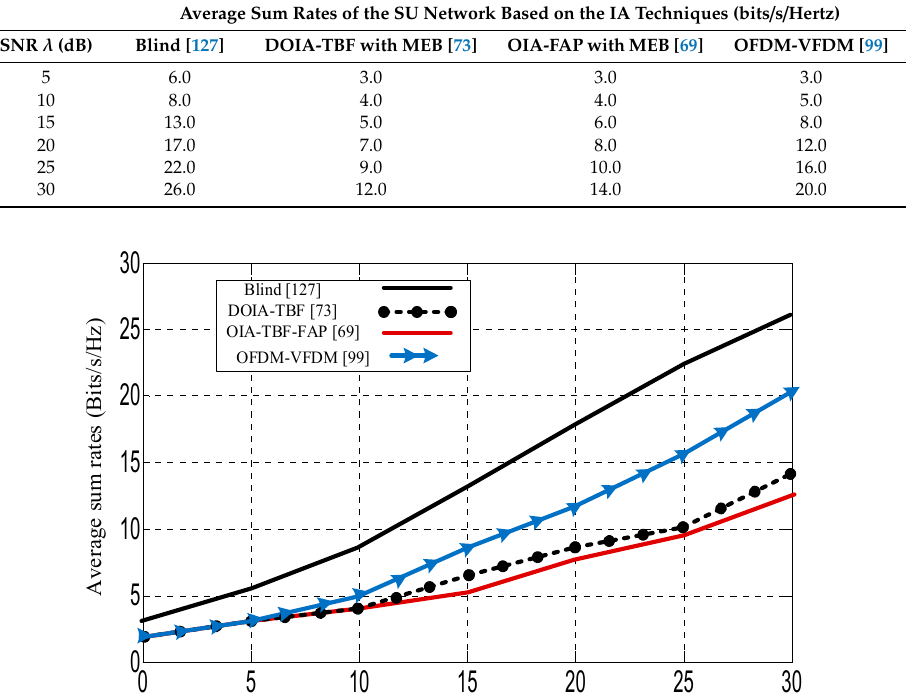
Figure 9. Average sum rates against typical SNR values for the second paradigm with ST-WF for the multiple SU MIMO link [69,73,99,127].